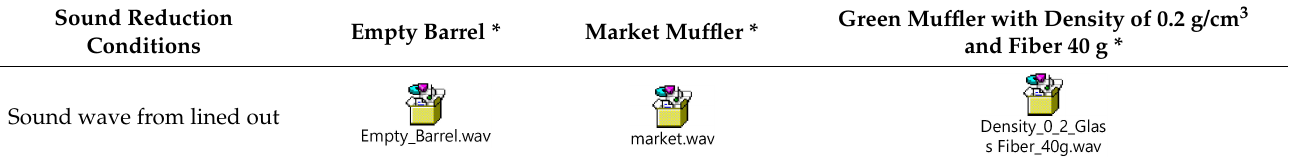
Table 6. A comparison of the sound